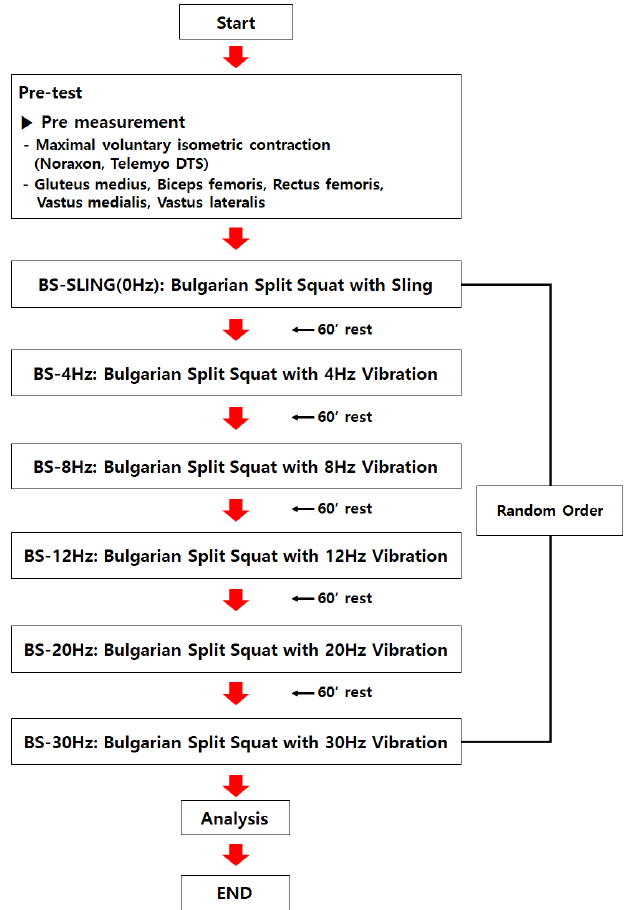
Figure 2. Block diagram of the experimental procedure.